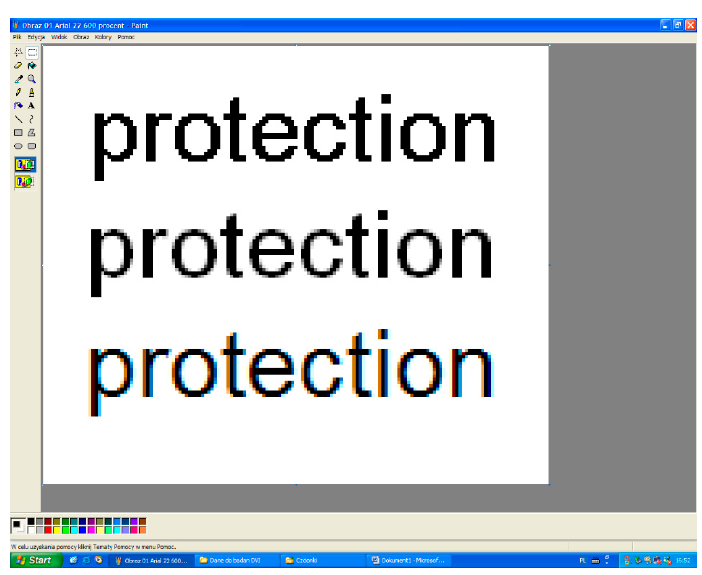
Figure 13. The displayed image on the test screen. Electronics 2019 , 8 , x FOR PEER REVIEW